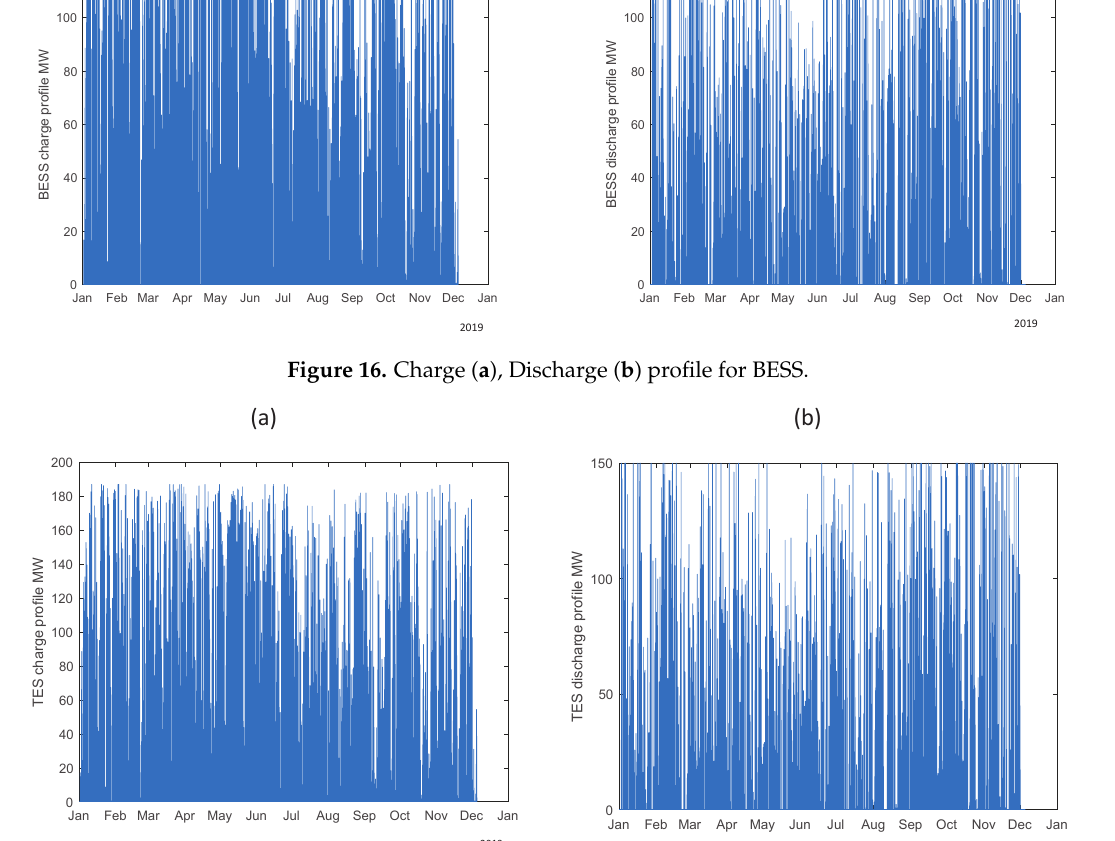
Figure 17. Charge ( a ), Discharge ( b ) profile for TESS.